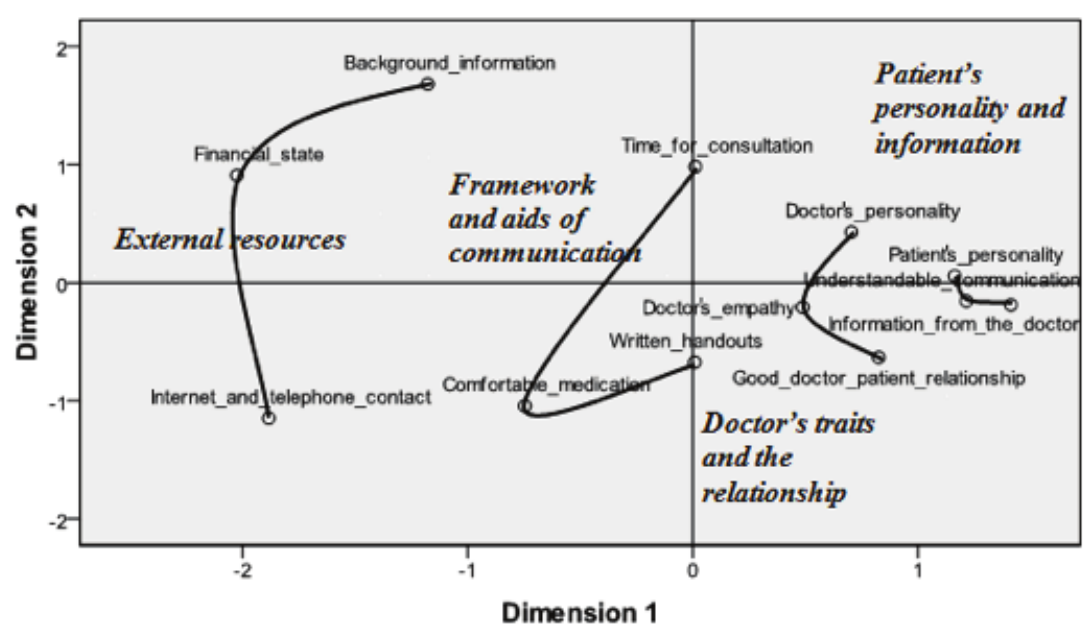
Questionnaire item categories